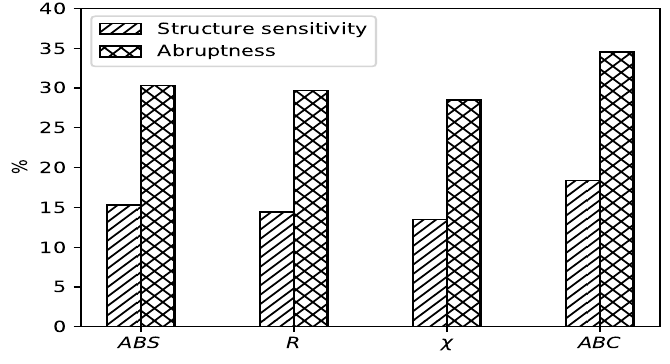
Figure 2: Structure sensitivity of ABS , R , χ , and ABC indices in the case of decane isomers. it is strongly correlated with the connectivity, atom-bond connectivity, and sum-connectivity indices. This indicates that the ABS index can be used to predict properties of molecules equally well (or better than) as by the earlier connectivity indices. Moreover, the ABS index performs slightly better than the aforementioned indices in predicting certain chemical properties of octane isomers; when comparing ABS and ABC indices, the ABS index outperforms the ABC index in six